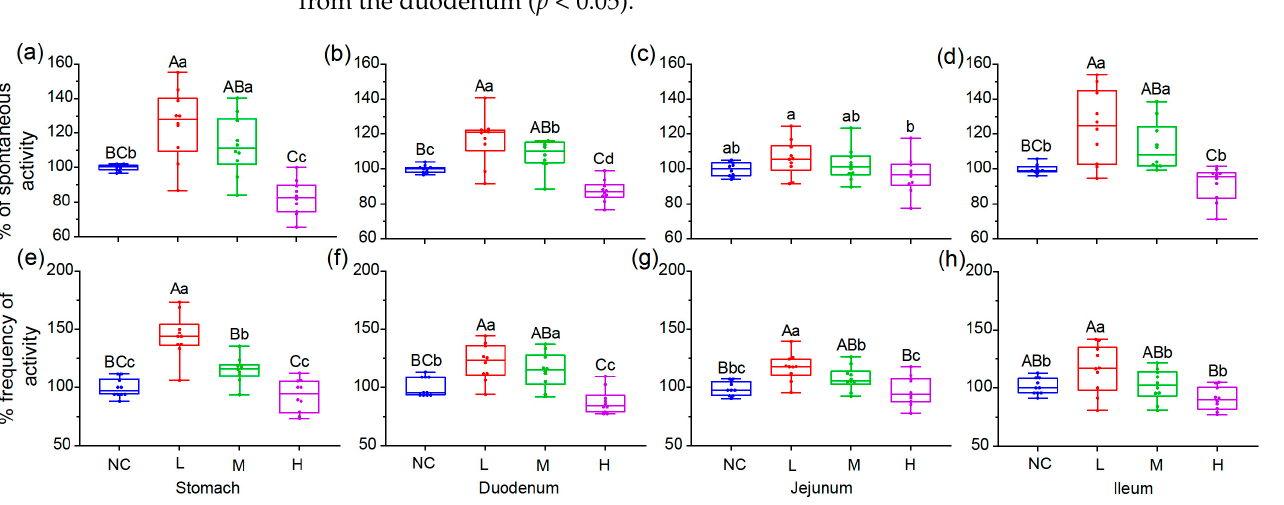
Figure 4. Effects of different concentrations of MJGT hydro extracts on the contraction of isolated muscle strips from different gastrointestinal tissues in vitro . The contraction is indicated by the percentage (%) of spontaneous activity ( a – d ) and the corresponding frequency ( e – h ) compared to the negative control (NC, 100%) n = 10 rats for each group. Capital and lowercase letters above the bar indicate the difference significance at 0.01 or 0.05 level, respectively.